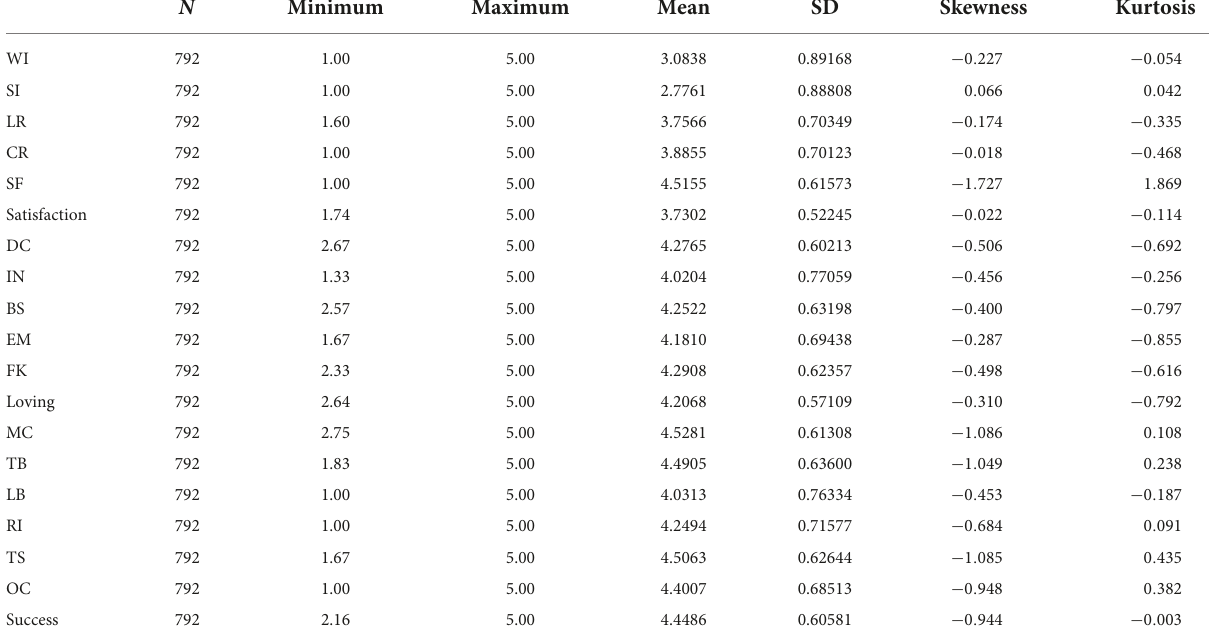
TABLE 3 Descriptive statistics of the scores.